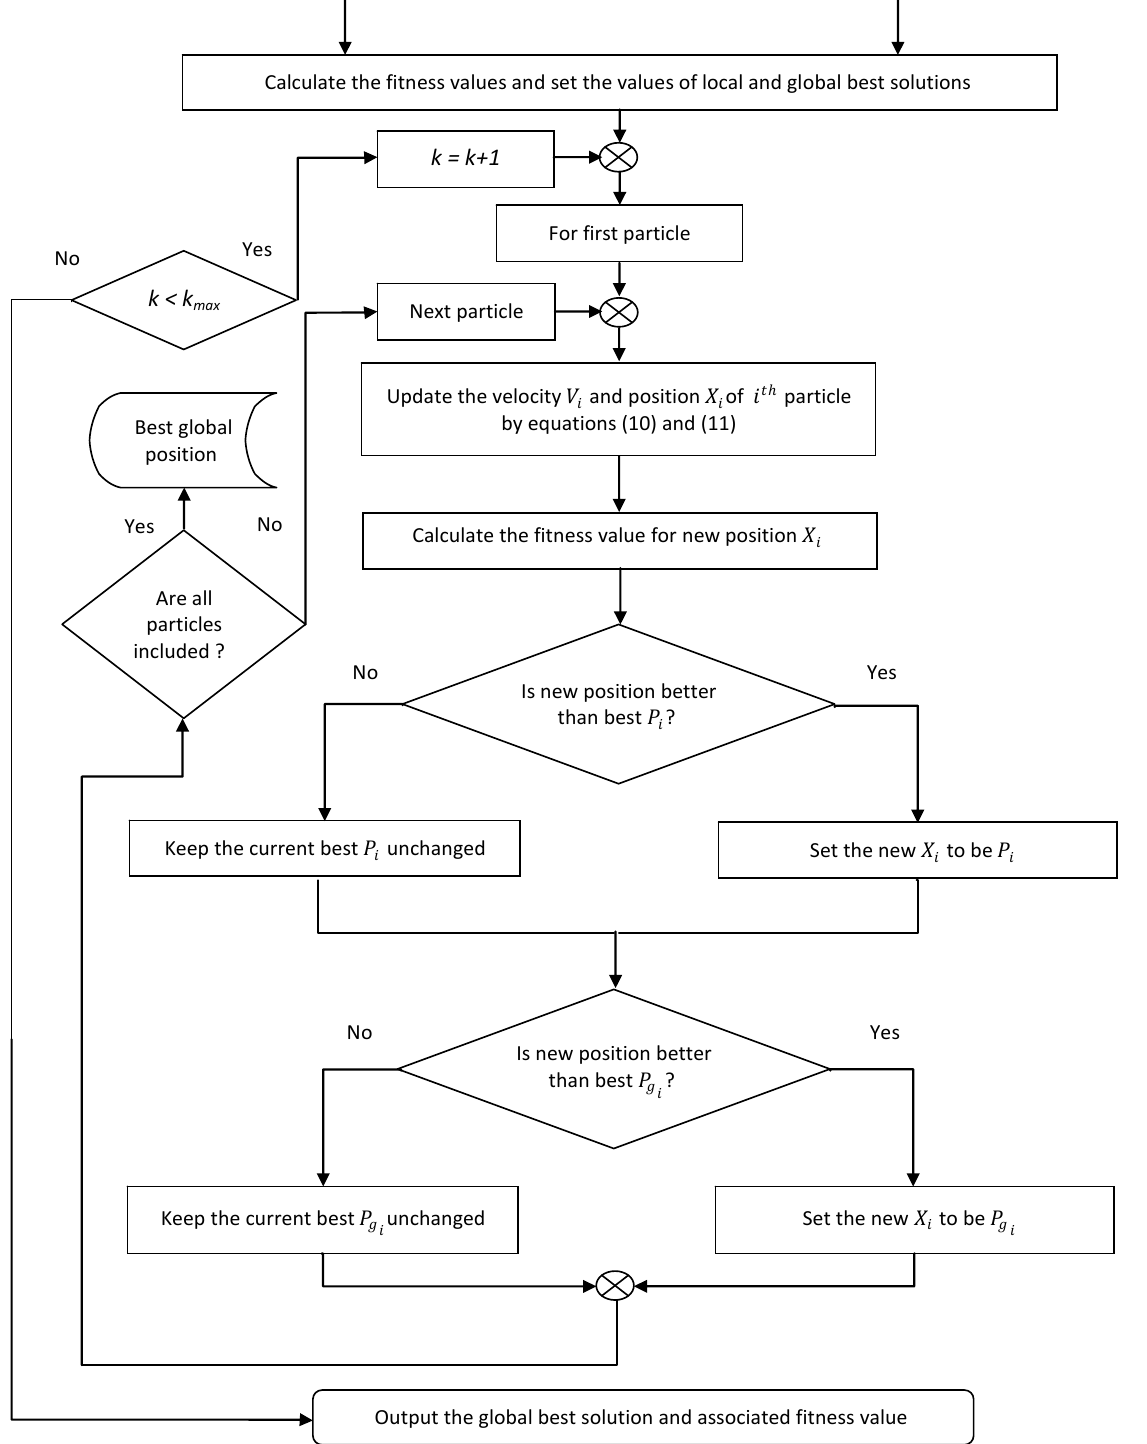
Figure 3. The flowchart of the PSO algorithm.